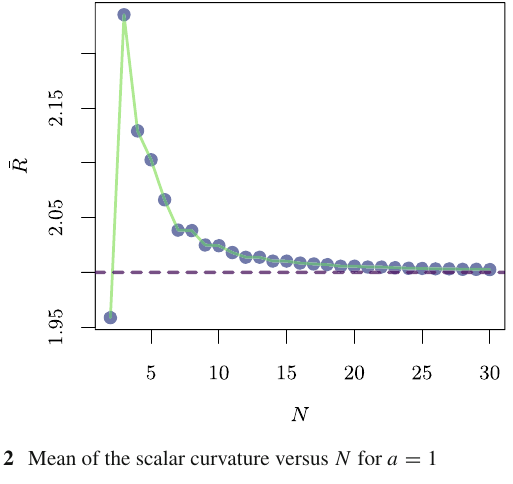
Fig. 2 Mean of the scalar curvature versus N for a = 1